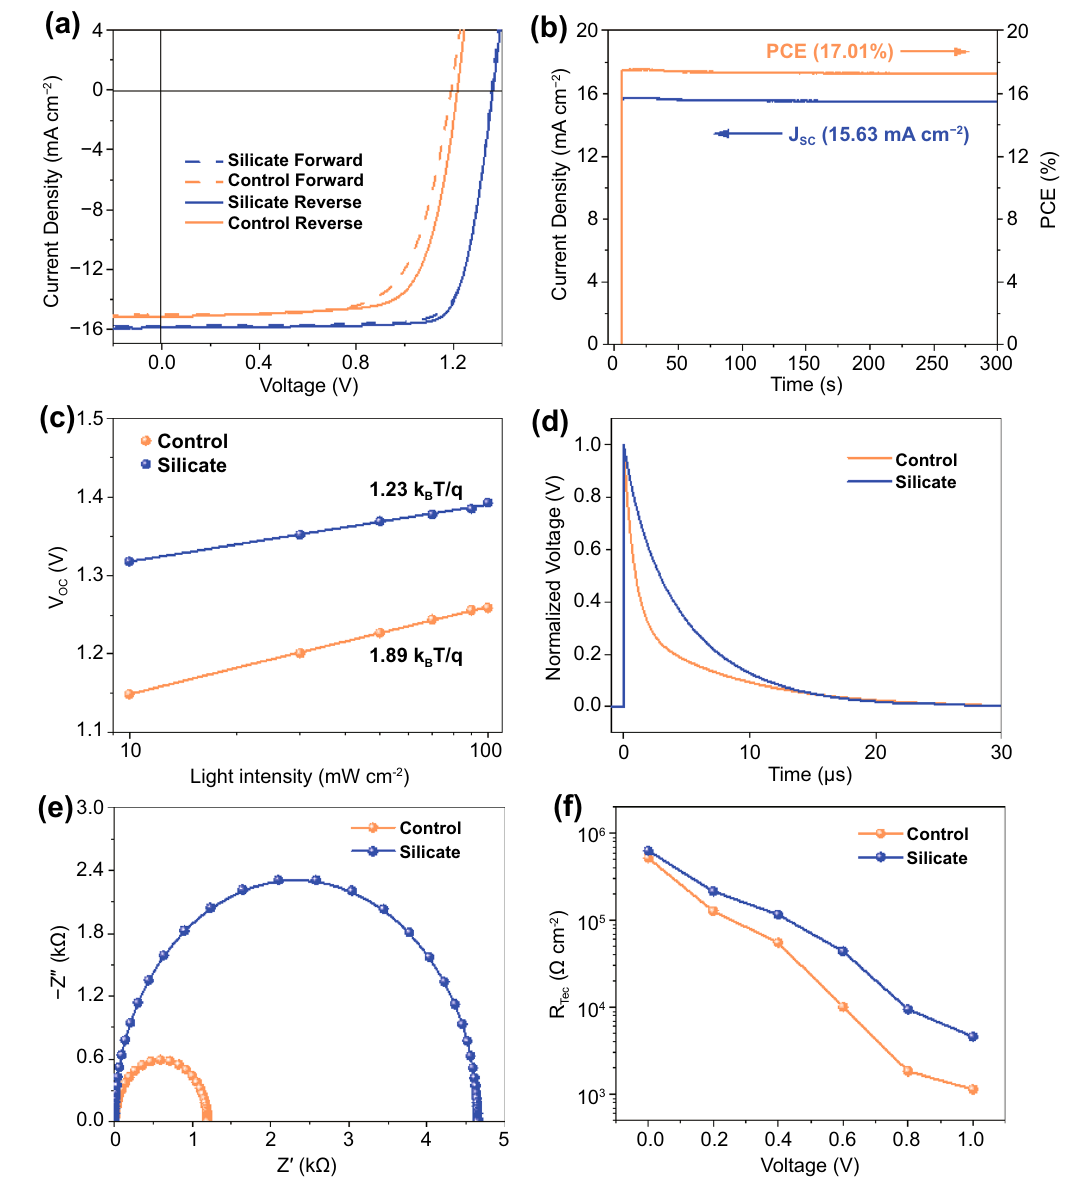
Fig. 5 a J–V curves of champion PSC devices measured under simulated AM 1.5G irradiation at different scan directions. b Steady-state power output (blue) and current density (red) of the champion cell measured at maximum power point (MPP) voltage as a function of time. c V OC val- ues of the control and silicate passivated CsPbI 2 Br device as a function of light intensity. d Transient photovoltage measurements for control and silicate passivated PSCs. e Nyquist plots of control and silicate passivated CsPbI 2 Br devices under dark with a bias voltage of 1.0 V. f Depend- ence of R rec on applied bias voltage for CsPbI 2 Br device with and without silicate passivation. R rec was obtained by fitting the EIS spectra at dif- ferent